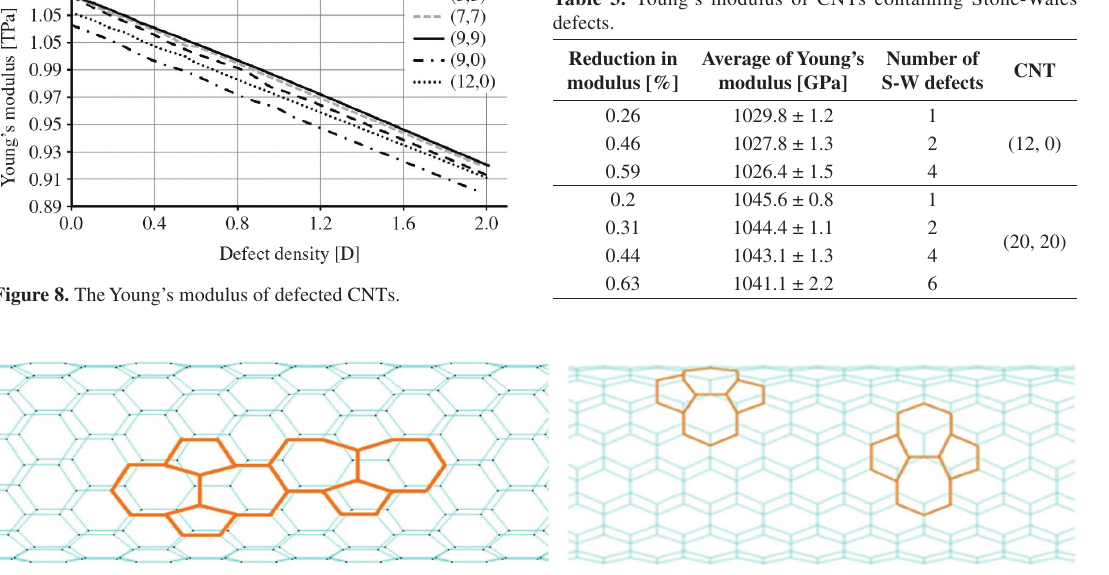
Figure 9. Finite element models of CNT incorporating S-W defects (20, 20) (right) and (12,0) (left).